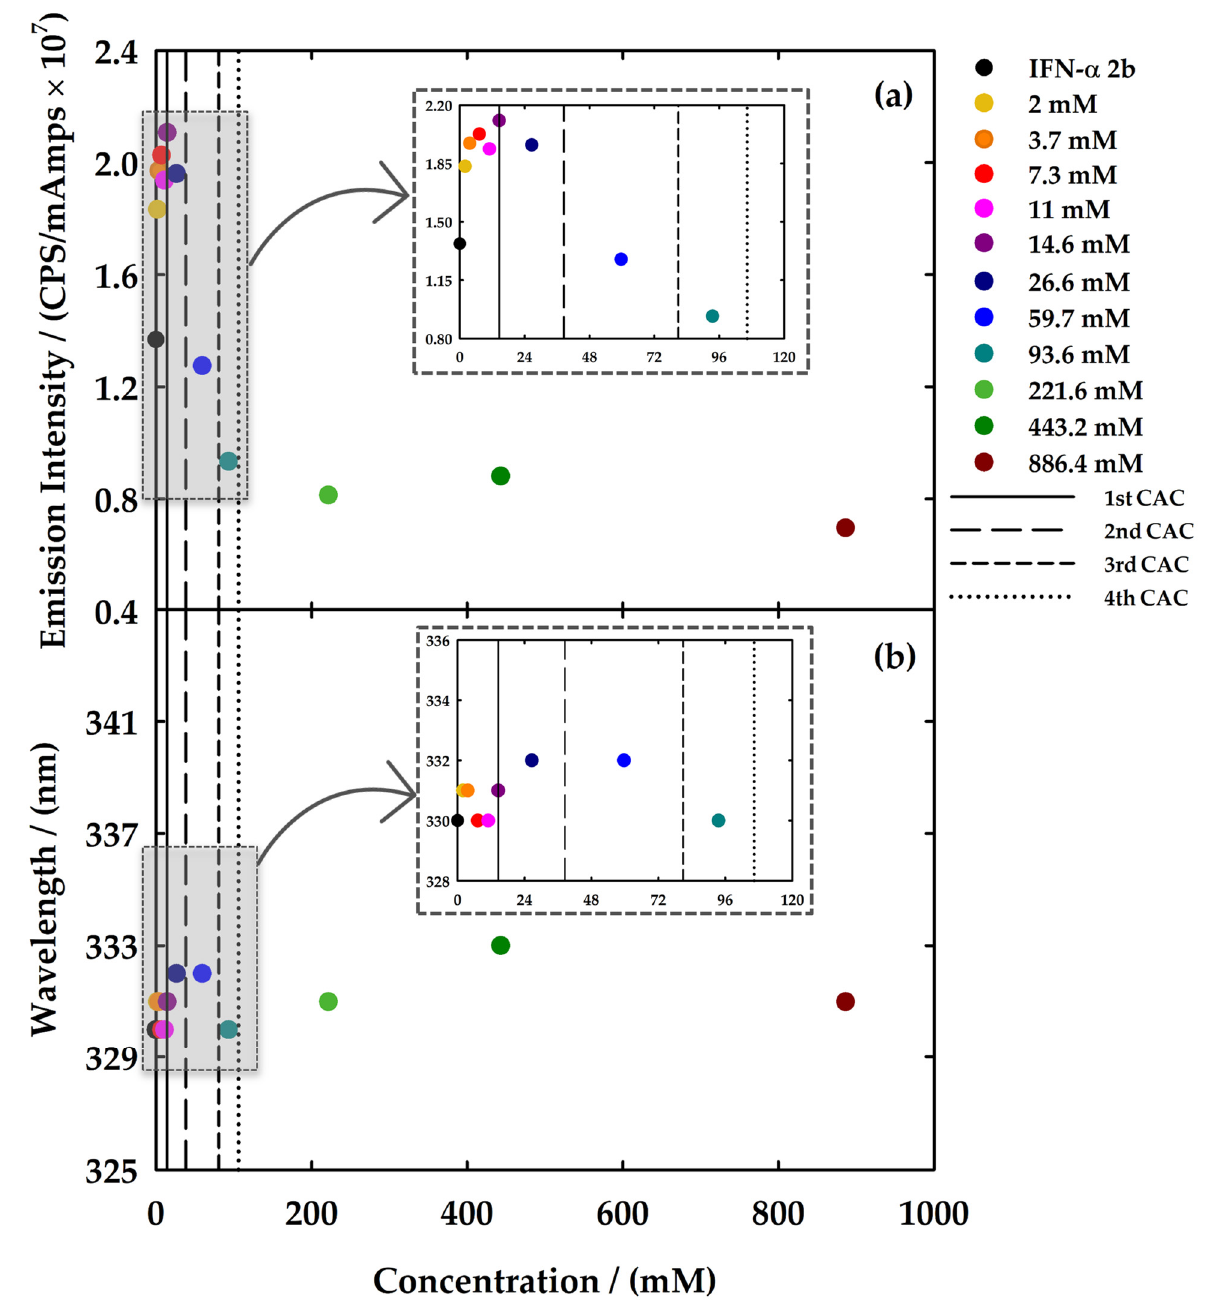
Figure 6. ( a ) Emission intensity and ( b ) wavelength variation of the maximum of the emission spectra of different concentrations of [C 2 C 1 Im][C 4 F 9 SO 3 ] with IFN- α 2b at 20 μ g/mL recorded at 280 nm. All samples were prepared in 5 mM NaH 2 PO 4 (pH = 7.4) and measured at 25 °C.